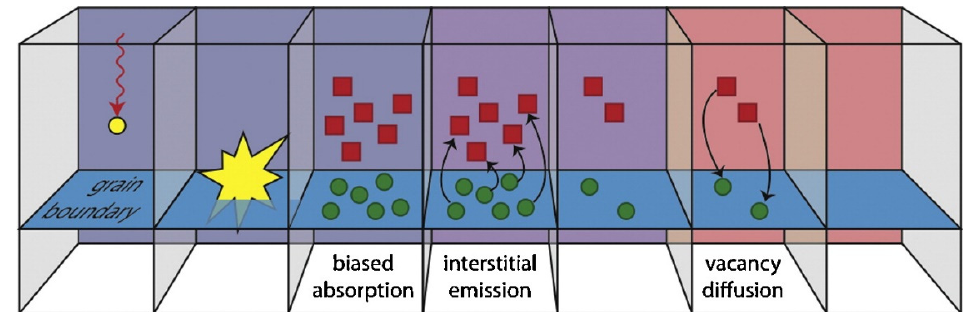
Figure 3. Schematic of the absorption–emission–recombination process during the interaction be- tween GB and the point defects, caused by collision cascades. Reproduced with permission from Ref. [25]. Copyright 2021 Clearance